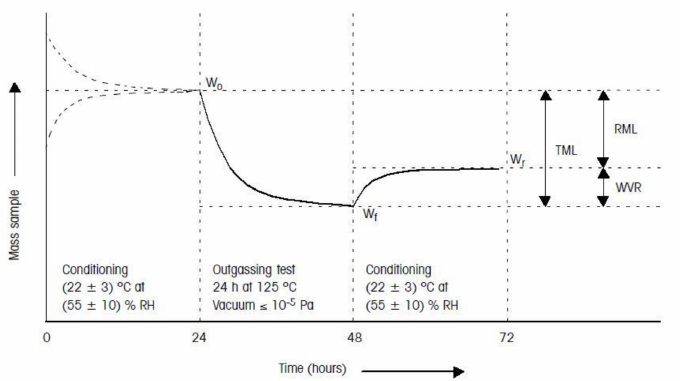
Figure 4. Outgassing test sequence according to ECSS standard [35]. The mass sample is plotted versus time.